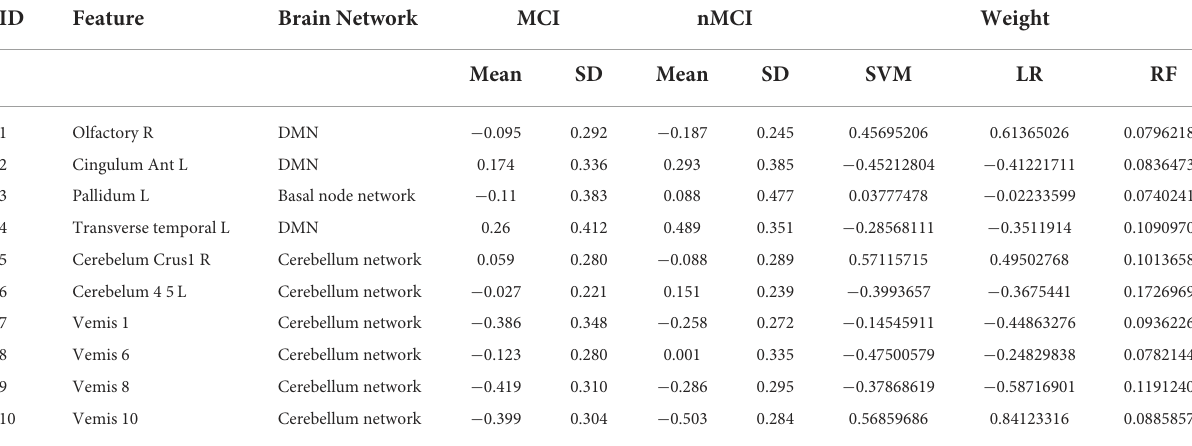
TABLE 2 The selected DC features set for discriminating the MCI from nMCI group.